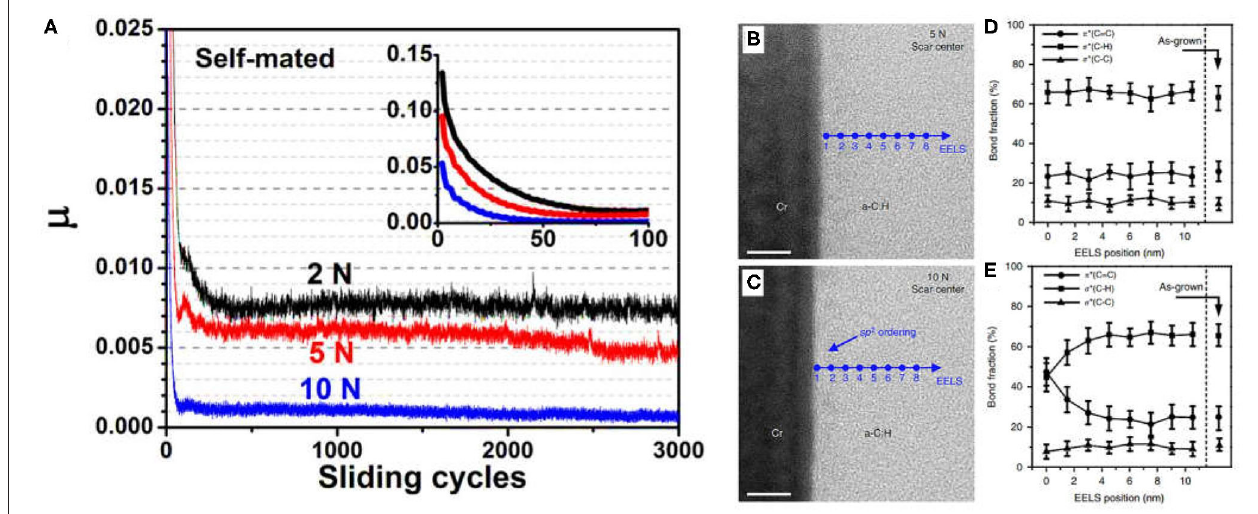
FIGURE 6 | (A) Friction coefficients of self-mated a-C:H at different normal loads. (B) BF-STEM image of the scar center at 5N (B) and 10N (C) . Bonding fraction of scar center at 5N (D) and 10N (E) calculated from EELS characterations. Adapted with permission from Chen et al. (2017) Copyright 2017, the